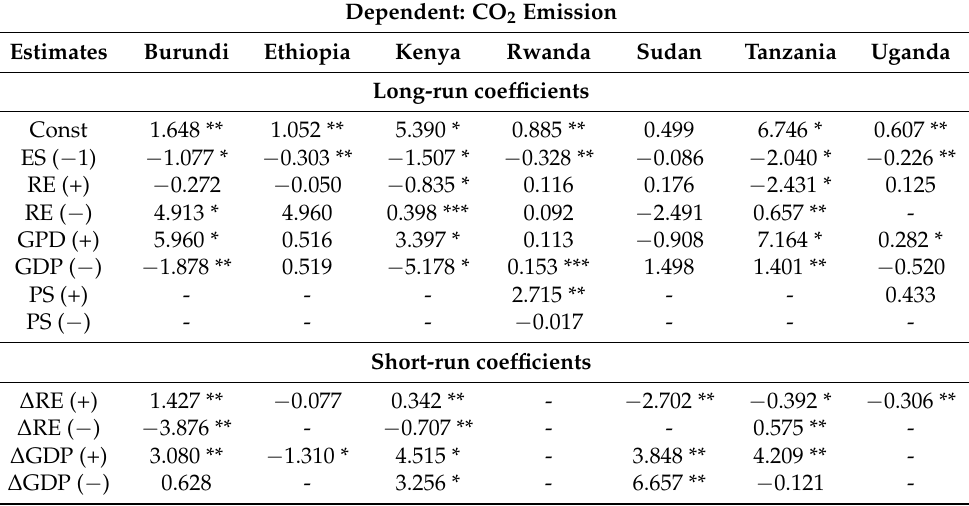
Table 8. Nonlinear autoregressive distributed lagged (NARDL) model coefficients for individual countries. Dependent: CO 2 Emission Estimates Burundi Ethiopia Kenya Rwanda Sudan Tanzania Uganda Const